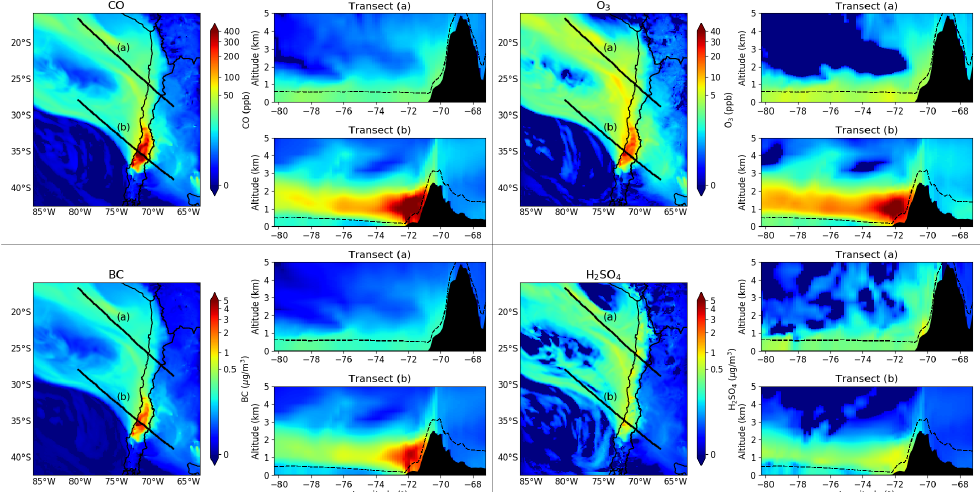
Figure 5. Excess concentrations of CO, O 3 , BC and H 2 SO 4 (particle phase) due to the contribution of fire emissions. Average for 25 to 29 January at the surface level and along two vertical transects. Each panel is composed of a map of surface concentrations ( left ), a northern transect along trajectory (a) shown in the surface map ( top right ), a southern transect along trajectory (b) shown in the surface map ( bottom right ). Black dashed line in the transects is the average mixing layer height along the transect. Black filled contours show terrain